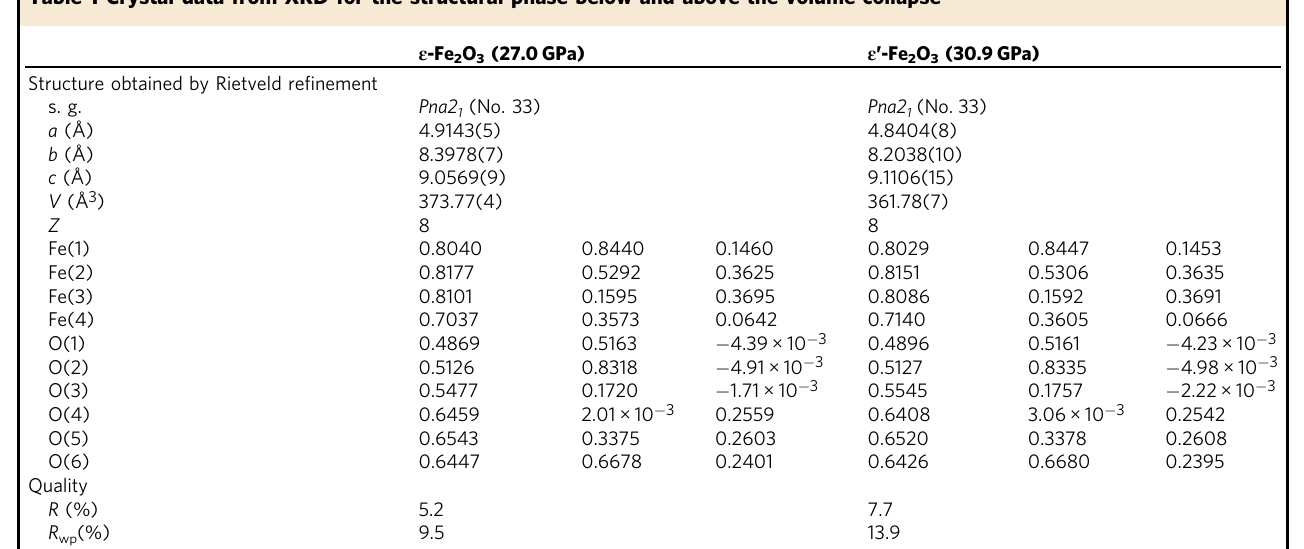
ε -Fe 2 O 3 (27.0 GPa)